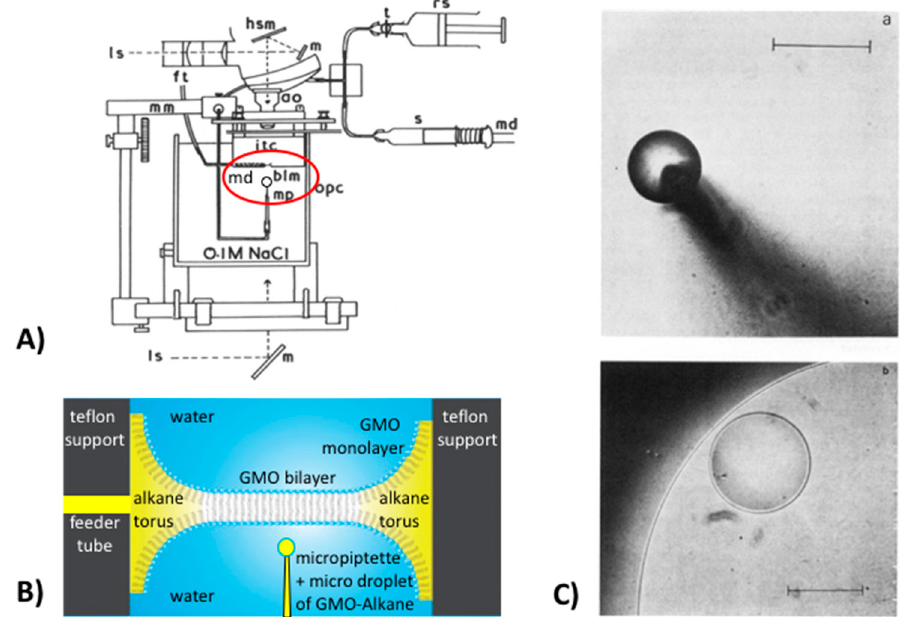
Figure 1. Measurement of high contact angles in black lipid membranes. ( A ) Diagram of the apparatus showing the micropipette (mp) with microdroplet (md) of Glyceryl Mono ‐ Oleate (GMO) ‐ alkane placed just beneath the black lipid membrane (blm) circled in red. ( B ) Schematic of the BLM formed in a Teflon support using a feeder tube, showing the GMO bilayer in the hole, in equilibrium with the GMO monolayer on the alkane torus, and the positioning of the micropipette with microdroplet ready to be inserted into the bilayer. ( C ) Photographic images of: (a) a droplet of monoolein 8.4 mM in squalene under 0.1 M NaCl on the end of a micropipette of tip external diameter 13.6 μ m; (b) the lens that was formed by touching the droplet to the black lipid film formed from the same solution. Bar equals 100 μ m. Adapted from [1].